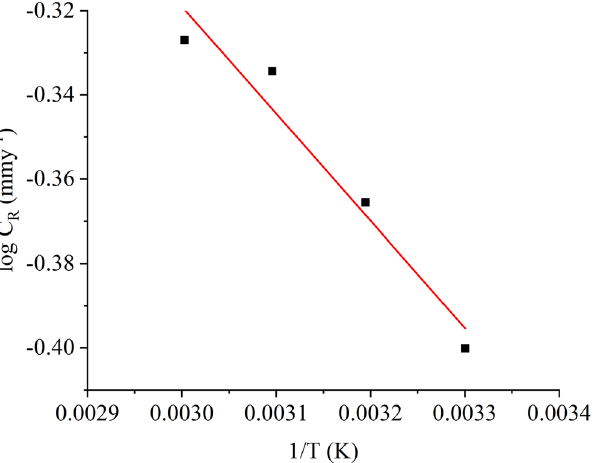
1 T of nonanedihydrazide optimised concentration (0.5 mM) for 5 h.